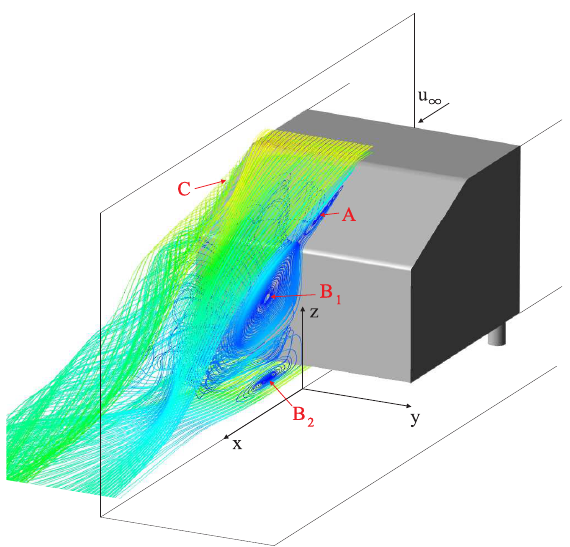
Figure 7. Vortex system in wake (schematic) [9].